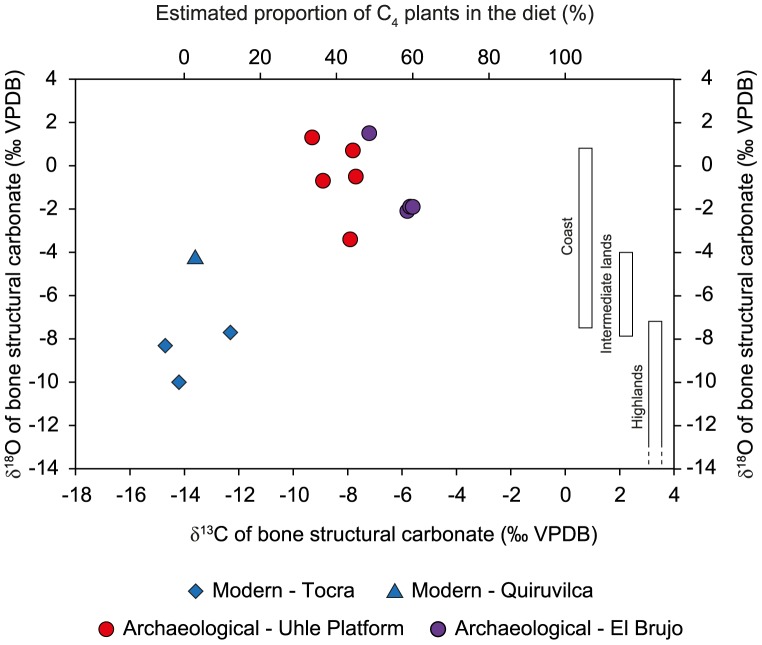
Isotopic composition of bone structural carbonate.Plot of δ13C and δ18O values (‰ VPDB) of bone structural carbonate of archaeological and modern highland domestic camelids. The proportion of C4 in the diet was reconstructed using estimated mean pre-industrial δ13C values of pure-C3 and pure-C4 feeders. Estimated ranges of δ18O values for animals raised in the three ecozones are represented by rectangles.